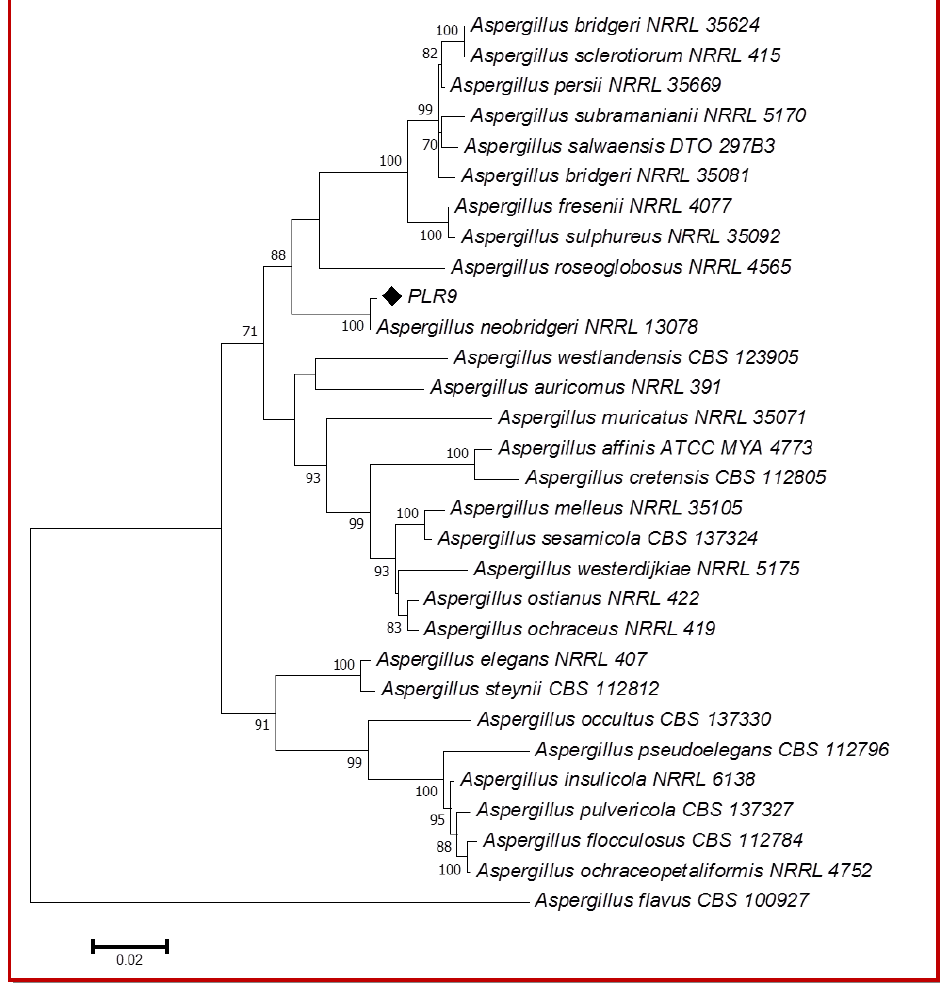
Figure 2: Phylogenetic tree generated by Maximum Likelihood analysis based on the combined alignment of ITS, BenA, and CaM sequences data. The tree is rooted with A. flavus CBS 100927. Maximum likelihood bootstrap values MLBS≥70 % are given at the